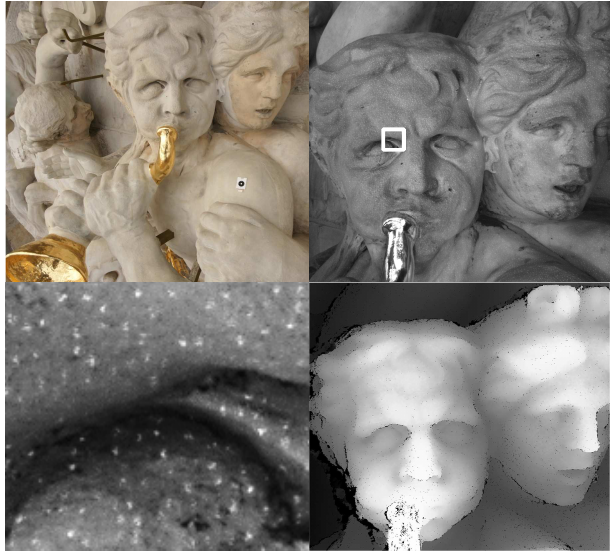
Figure 4: Data recording example (project: see section 7). Upper left: Color image of the scene acquired by DSLR. Upper right: grey image acquired by the sensor. The white rectangle depicts the magnified area of the lower left image, showing the texture with the Kinect speckle pattern. Lower right: computed depth